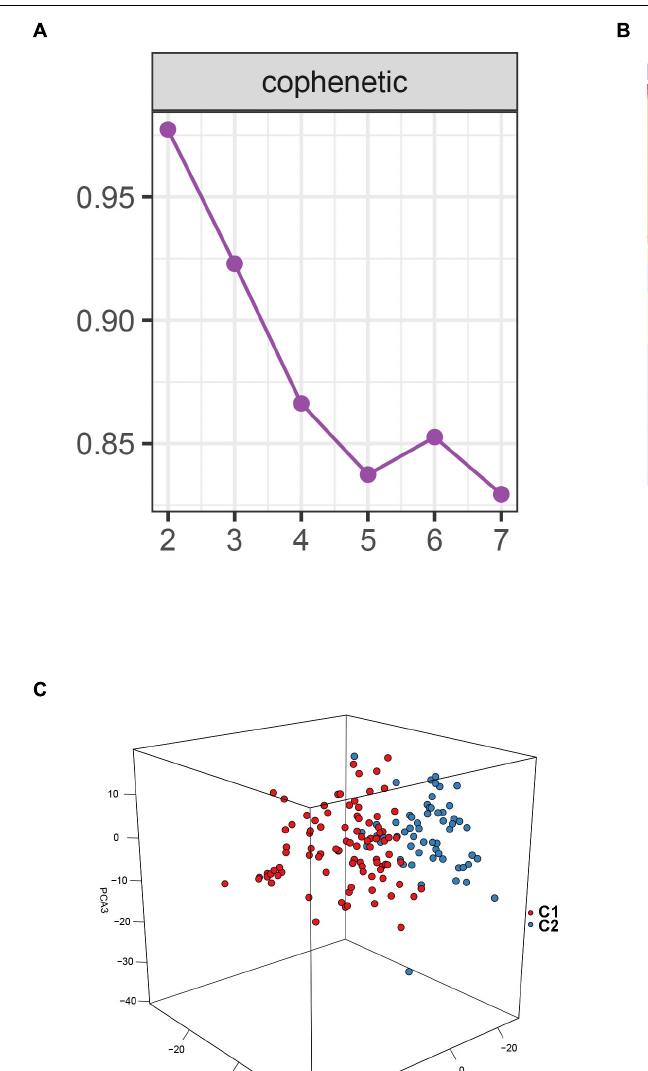
Frontiers in Molecular Biosciences |